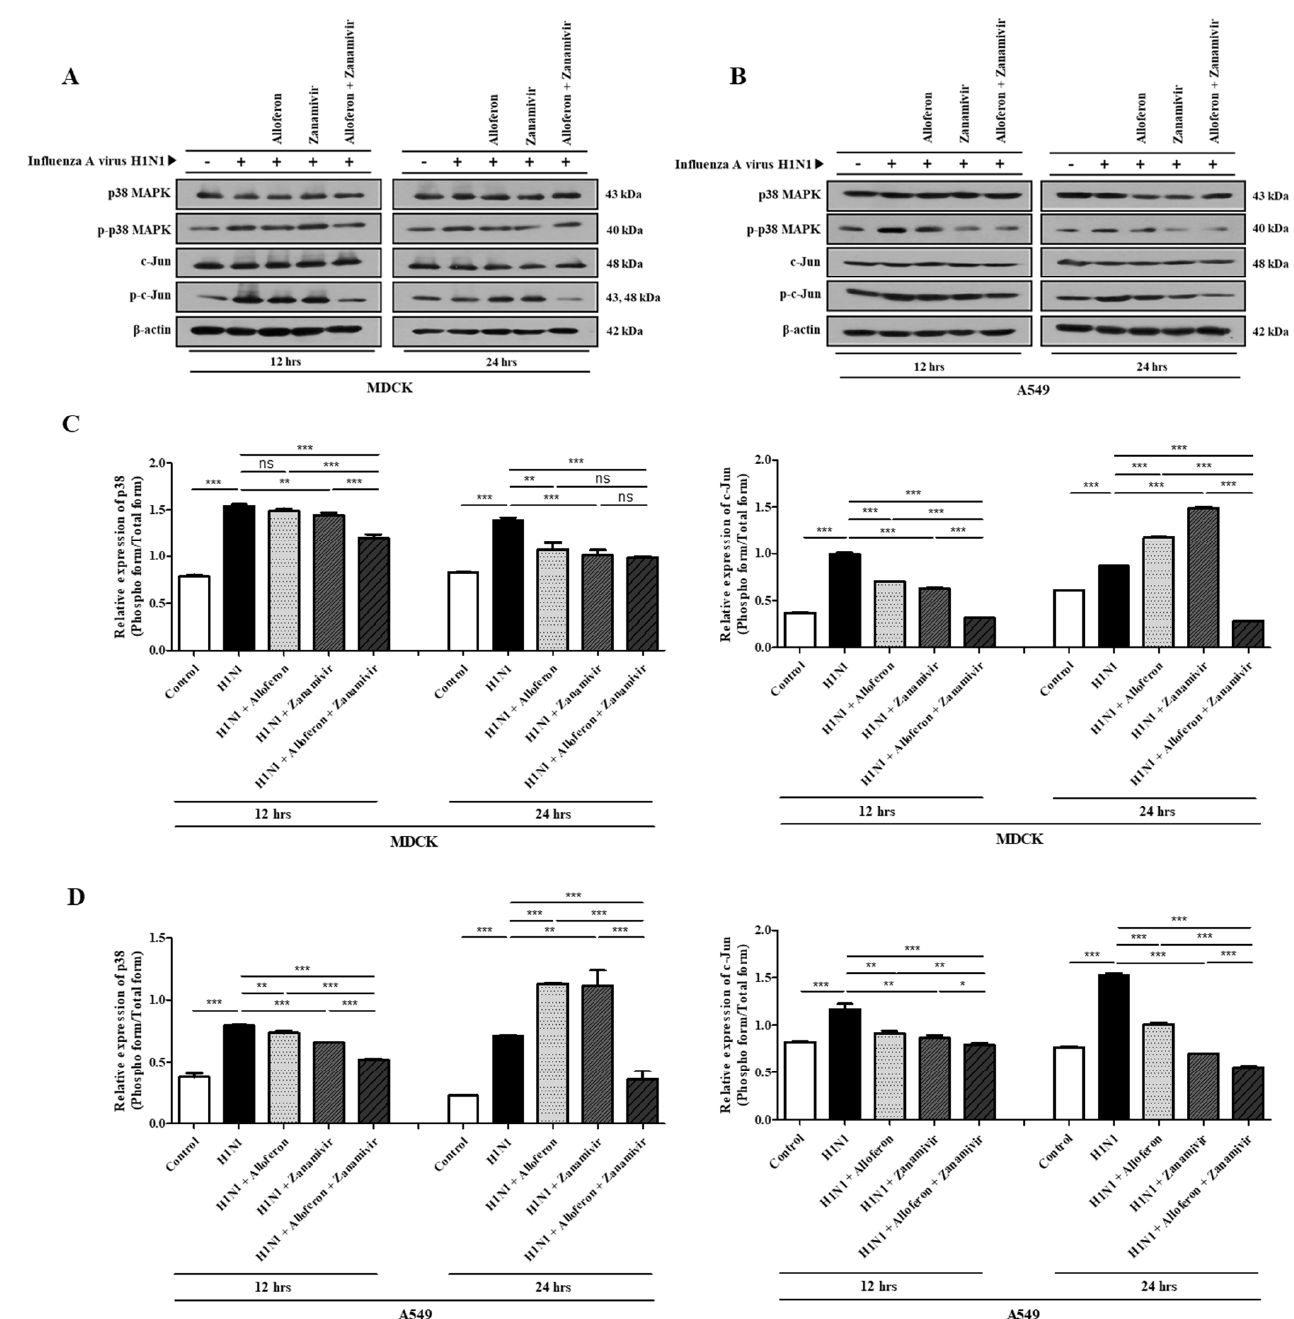
Figure 3. The antiviral effects of combined treatment with alloferon (0.5 µ g/mL) and zanamivir (35 µ g/mL) are mediated by inhibition of the p38 MAPK and JNK signaling pathways. MDCK ( A ) and A549 ( B ) cells were cultured in the presence or absence of alloferon and/or zanamivir for 12 and 24 h. Cell lysates were prepared. and western blot analysis was performed for detection of changes in activation of p38 MAPK and JNK, as described in the Materials and Methods Section 4. Results are representative of more than three independent experiments. ( C , D ) Calculation of the relative expression of the phospho form/total form was performed using Image J software. * p < 0.1, ** p < 0.01, *** p < 0.001, NS; no significant.